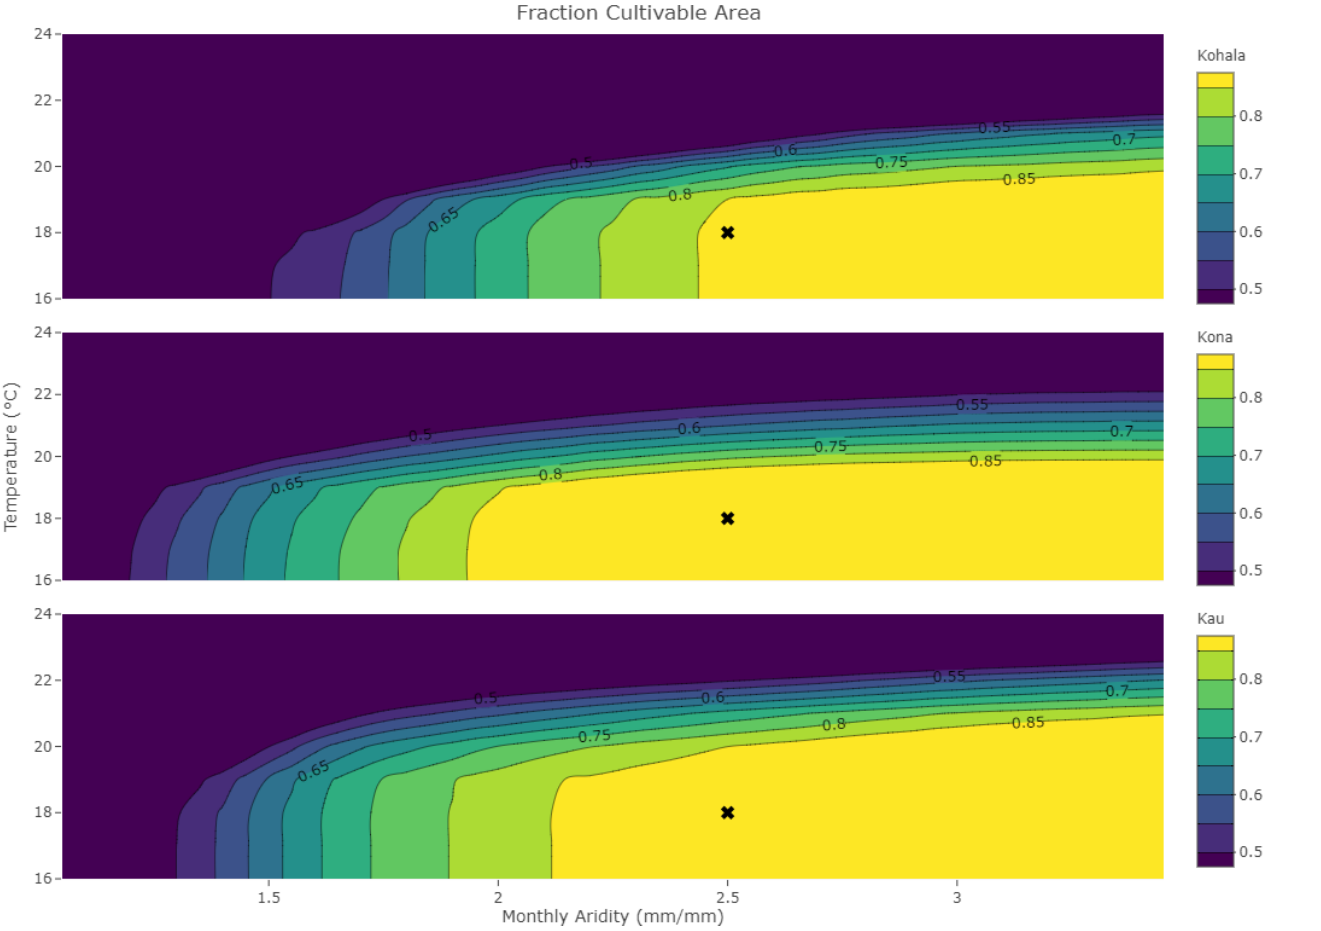
Figure A2.2 Fraction of field system that meets thresholds for monthly air temperature and monthly aridity for at least one month of the year: Kohala (top), Kona (middle), and Ka ʻū (bottom). Monthly air temperature criterion (minimum) indicated on the y-axis and monthly aridity criterion (maximum) indicated on the x-axis. Marker at aridity = 2.5 and temperature = 18 ° C indicates the fixed thresholds used for visualizing seasonal cultivation